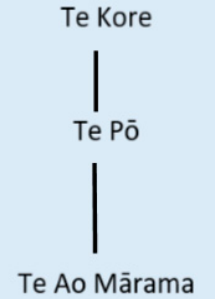
Figure 2. Whakapapa sequence representing Te Ao M ā ori/the M ā ori world.